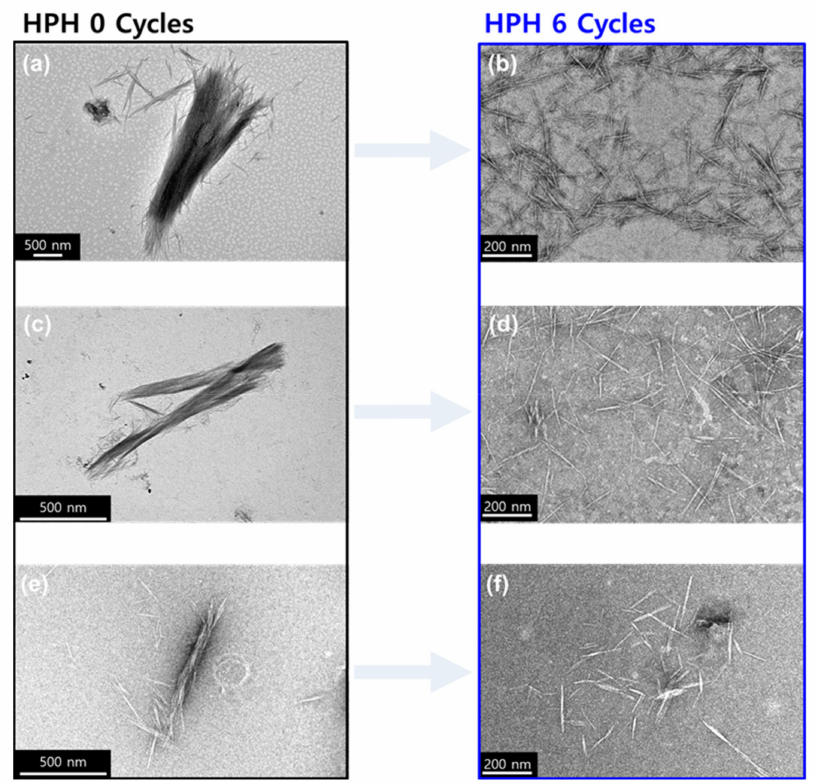
Figure 2. TEM images of negatively stained CNCs obtained by sulfuric acid hydrolysis, from three different materials, with or without mechanical treatment: ( a ) MCC-untreated, ( b ) MCC-6 cycles, ( c ) SWP-untreated, ( d ) SWP-6 cycles, ( e ) CP-untreated, ( f ) CP-6